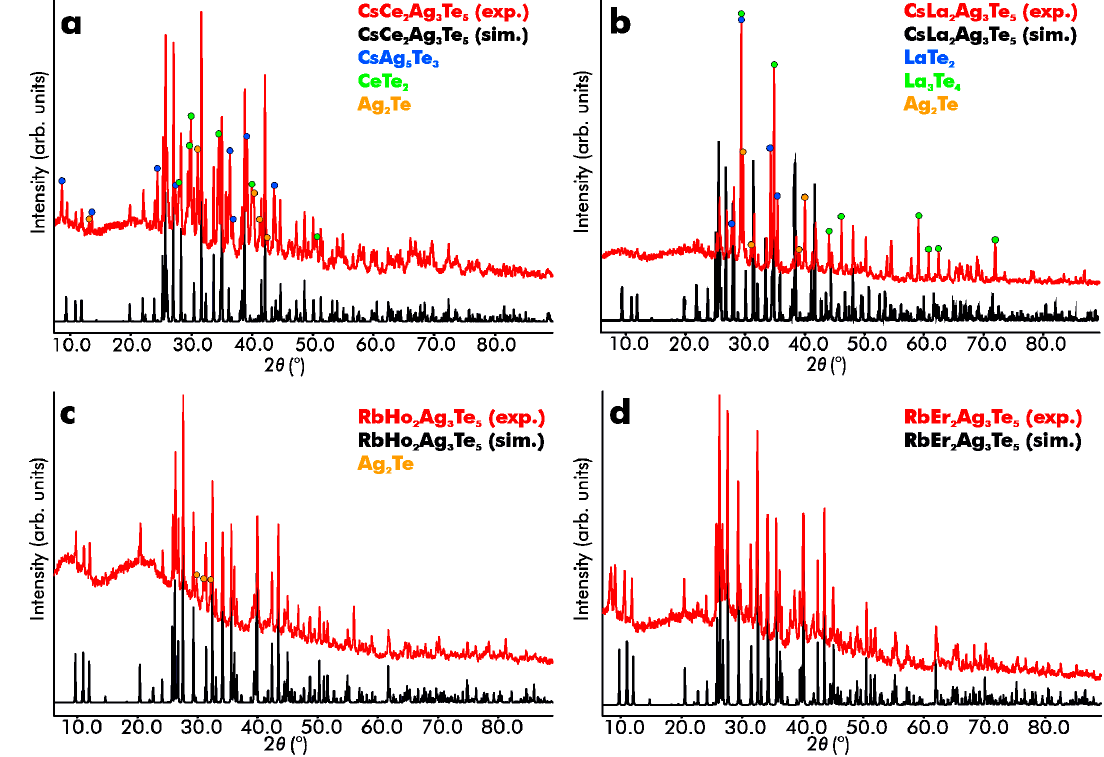
Figure 1. Experimental and theoretical powder X-ray diffraction patterns of ( a ) CsCe 2 Ag 3 Te 5 , ( b ) CsLa 2 Ag 3 Te 5 , ( c ) RbHo 2 Ag 3 Te 5 , and ( d ) RbEr 2 Ag 3 Te 5 ; reflections arising from side-products [23–27] are marked by the diverse circles. In the experimental powder X-ray diffraction pattern of the RbEr 2 Ag 3 Te 5 -containing sample, there are also reflections (below 10° and between 30° and 40°), which could not be assigned to the quaternary telluride, and originate from an unknown phase.